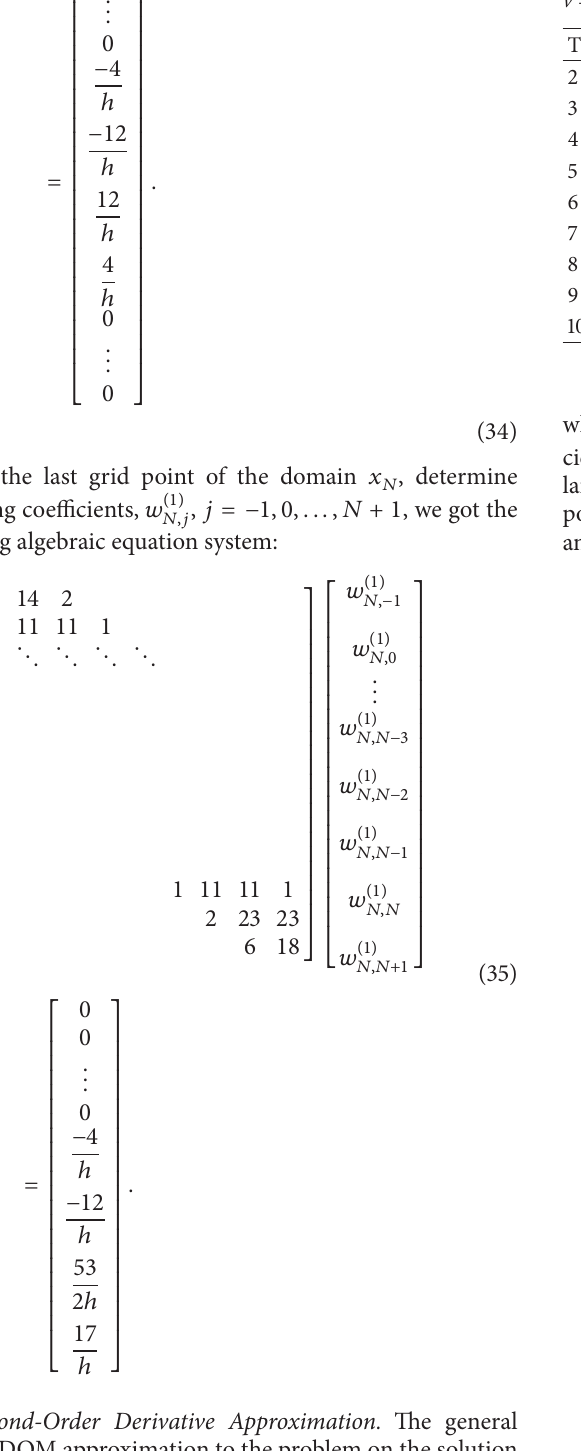
Table 1: 𝐿 2 and 𝐿 ∞ error norms for ℎ = 0.005 , Δ𝑡 = 0.01 , and V =